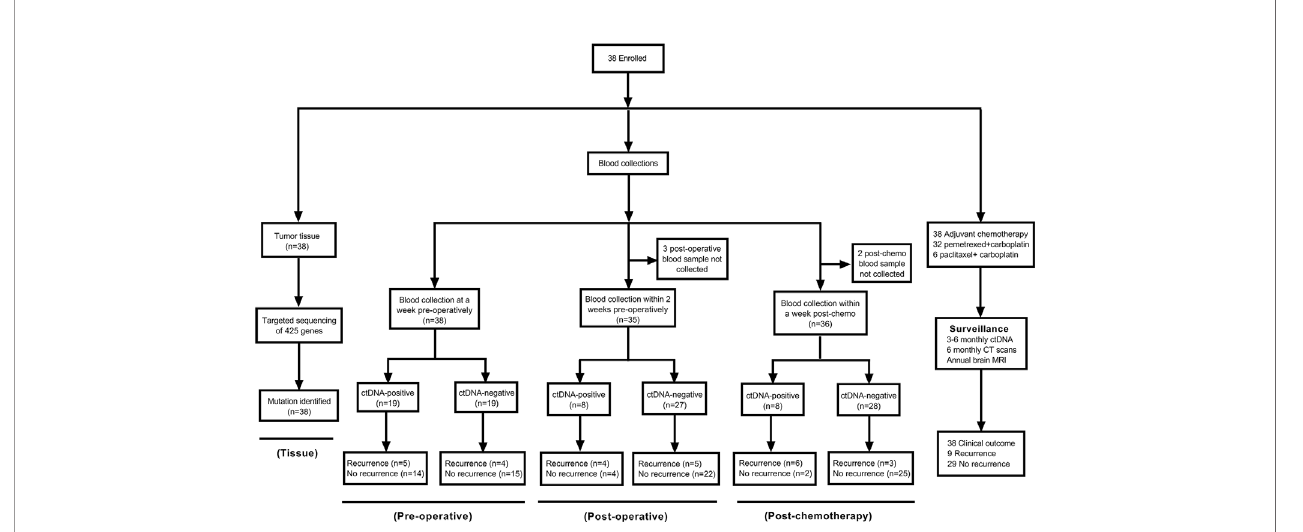
FIGURE 1 | Patient enrollment, sample collections, follow-up, and